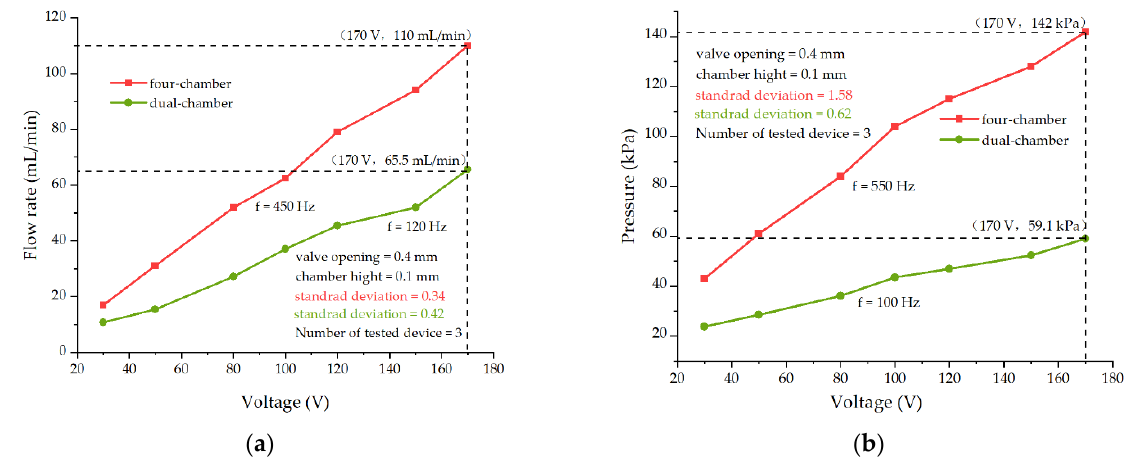
Figure 8. The relationship between the output performance of the multi-chamber series micropump vs. the frequency and voltage. ( a ) The relationship between flow rate and frequency at 100 V. ( b ) The relationship between pressure and frequency at 100 V.